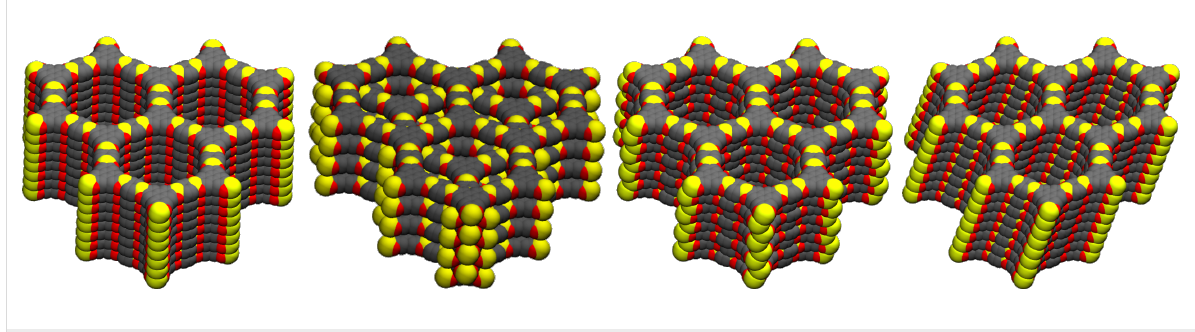
Figure 3: Layer stackings considered: AA, AB, serrated and inclined.